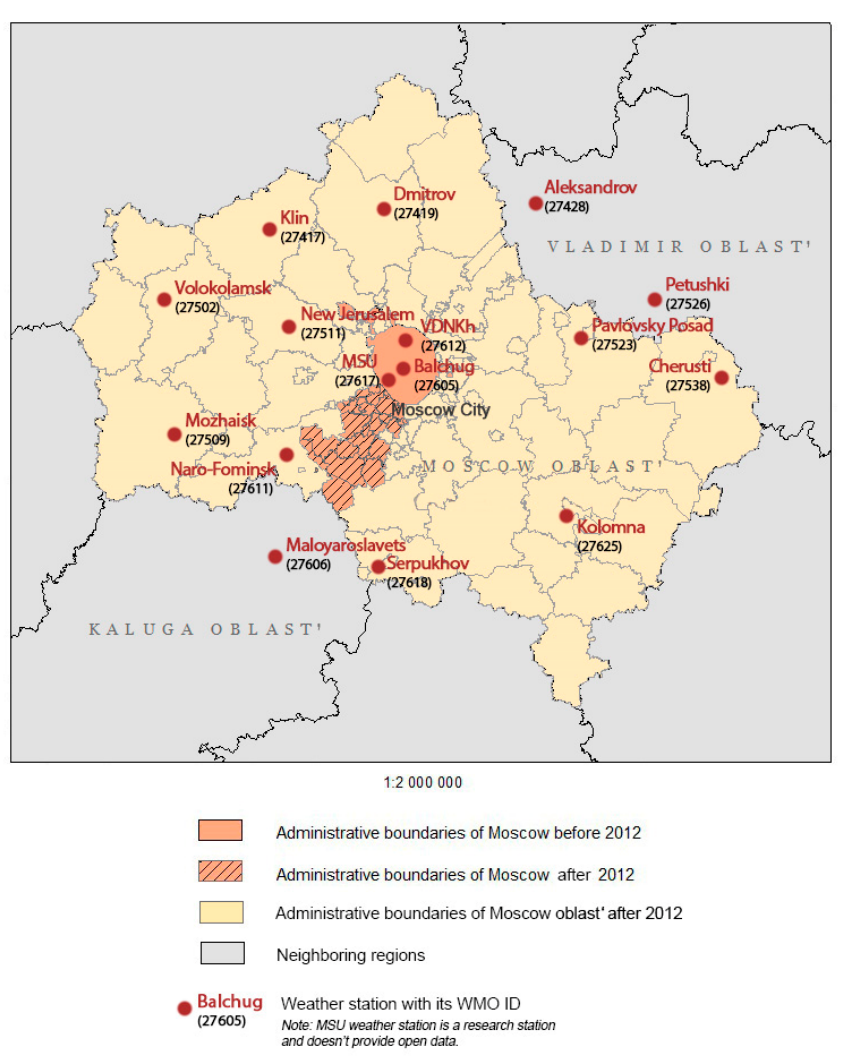
Figure 3. Moscow region geographical position.